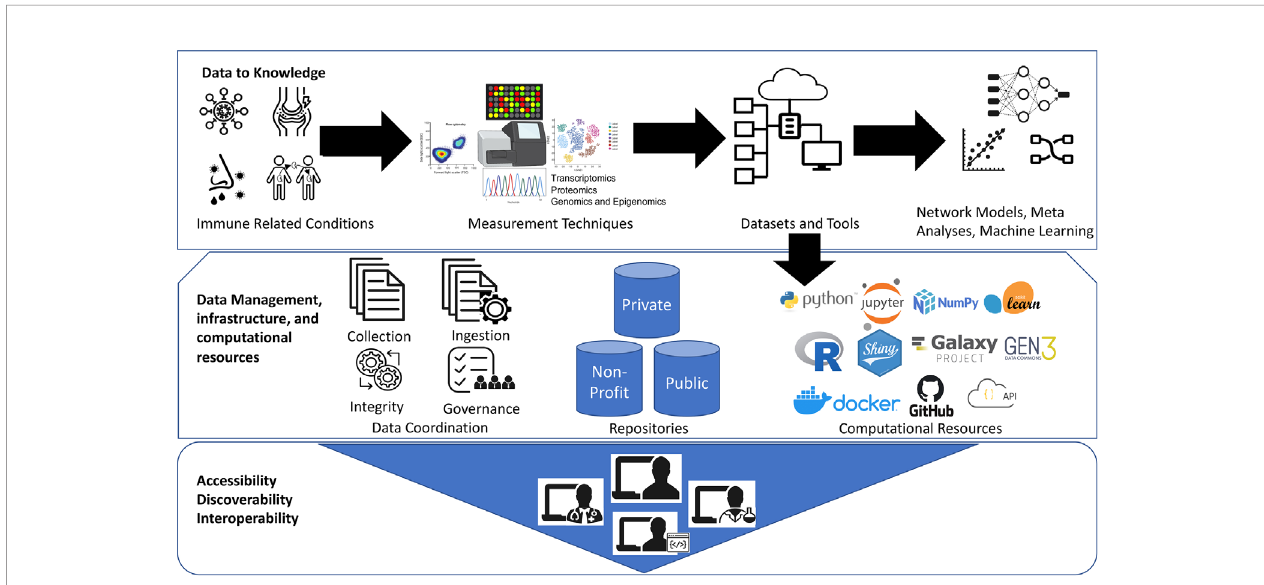
FIGURE 1 | Democratization of datasets and computational tools. The Jupyter logo was used under Copyright © 2017 Project Jupyter Contributors. https://github. com/jupyter/jupyter.github.io/blob/master/assets/main-logo.svg; The Scikit learn logo is under Copyright © The scikit-learn developers. Source:-https://commons. wikimedia.org/wiki/File:Scikit_learn_logo_small.svg; NumPy logo source:- The NumPy logo is created by NumPy Team, 2020; https://github.com/numpy/numpy/ blob/main/branding/logo/logomark/numpylogoicon.svg; Python logos are trademarks or registered trademarks of the Python Software Foundation, used with permission from the Foundation. Source:- https://legacy.python.org/community/logos/; Galaxy Project: https://galaxyproject.org/images/galaxy-logos/; Gen3:- The logo was used under the permission from Center for Translational Data Science at University of Chicago. Shiny- Shiny are trademarks of RStudio, PBC. https:// github.com/rstudio/hex-stickers/blob/master/PNG/shiny.png; The R logo is © 2016 The R Foundation. (CC-BY-SA 4.0); Docker- Docker and the Docker logo are trademarks of Docker, Inc. in the United States and/or other countries. https://www.docker.com/company/newsroom/media-resources; Github- GITHUB®, the GITHUB® logo design are exclusive trademarks registered in the United States by GitHub, Inc,